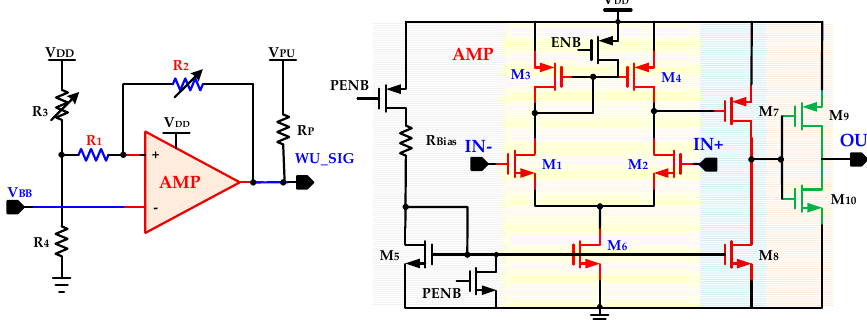
Figure 12. Hysteresis comparator with positive feedback and amplifier.